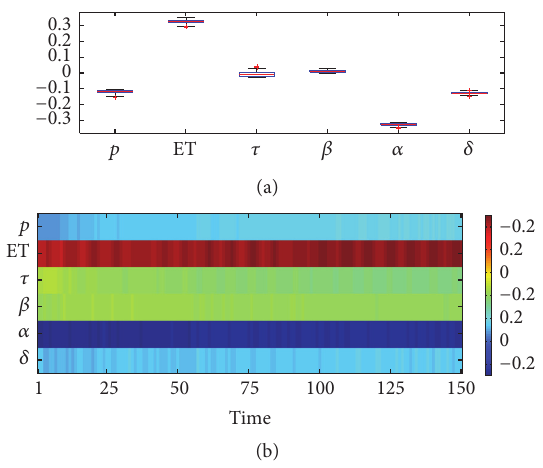
Figure 9: Mean switching times versus 𝑝 ; the parameter values are fixed as follows: 𝑝 = 0.1, 𝜏 = 0.3, 𝜎 = 0.66, 𝛽 = 4 , and 𝛿 = 2.0 ; the initial density of prey and predator (𝑥 0 , 𝑦 0 ) = (0.2, 0.5) . (a) ET = 0.6 and 𝛼 = 2,2.2, 2.5, 2.8, 3.2 , respectively. (b) 𝛼 = 2 and ET = 0.85, 0.80, 0.75, 0.70, 0.60 , respectively.